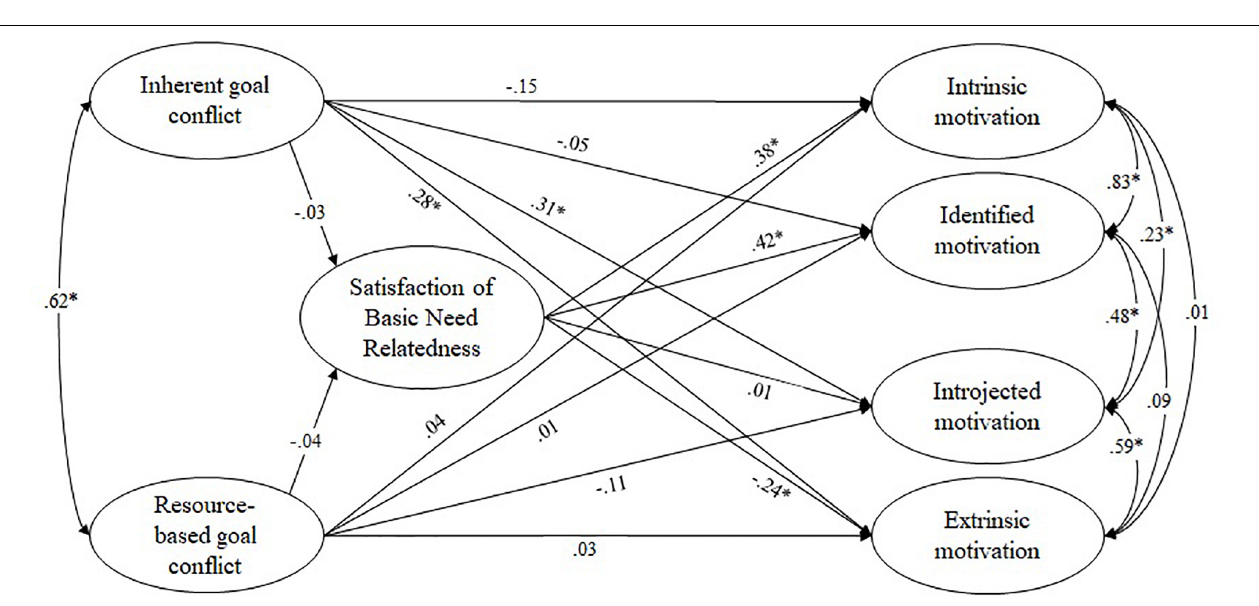
FIGURE 5 | Path coefficients from structural equation modeling: frequency of experiencing goal conflict affecting teaching motivation via the satisfaction of the basic need for competence. Figure depicts standardized beta weights, correlations between latent variables were specified as residual error correlations; * p < 0.05.